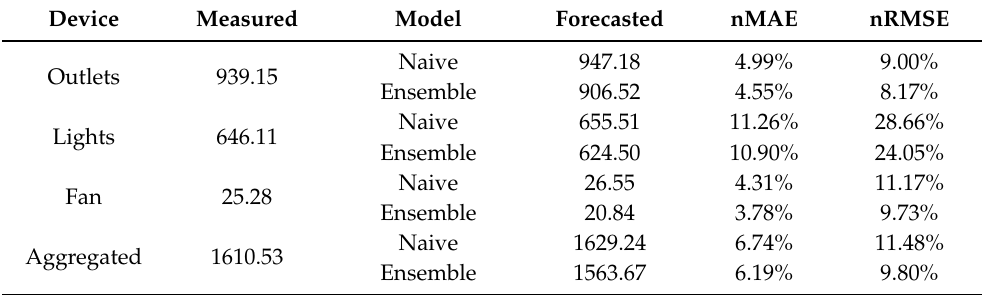
Figure 2. Results of Net Load Forecast and ground truth on the selected part of test dataset (12 to 19 September 2019). Table 5. Energy values (kWh) of load (ensemble) forecast, naive forecast, and measurements for whole test dataset on open-space B2.2 of INESC